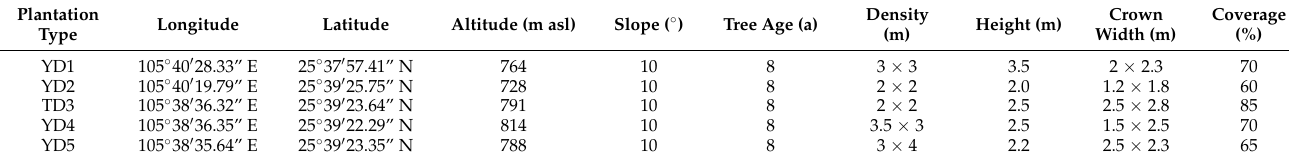
Table 1. General information of